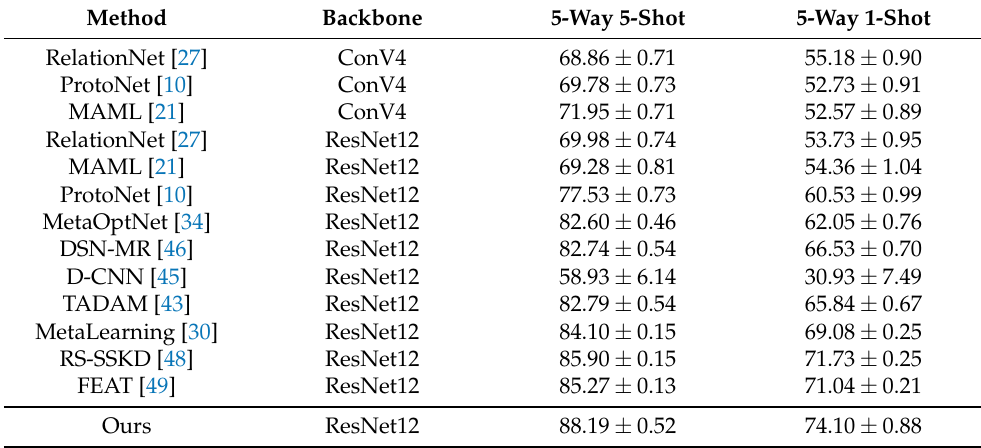
Table 3. The few-shot classification accuracies with 95% confidence over 600 episode intervals in the RSD46-WHU.